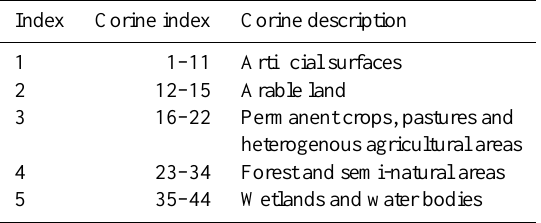
Table 3. Correspondance between Corine Land Cover database and the five land cover types used in this